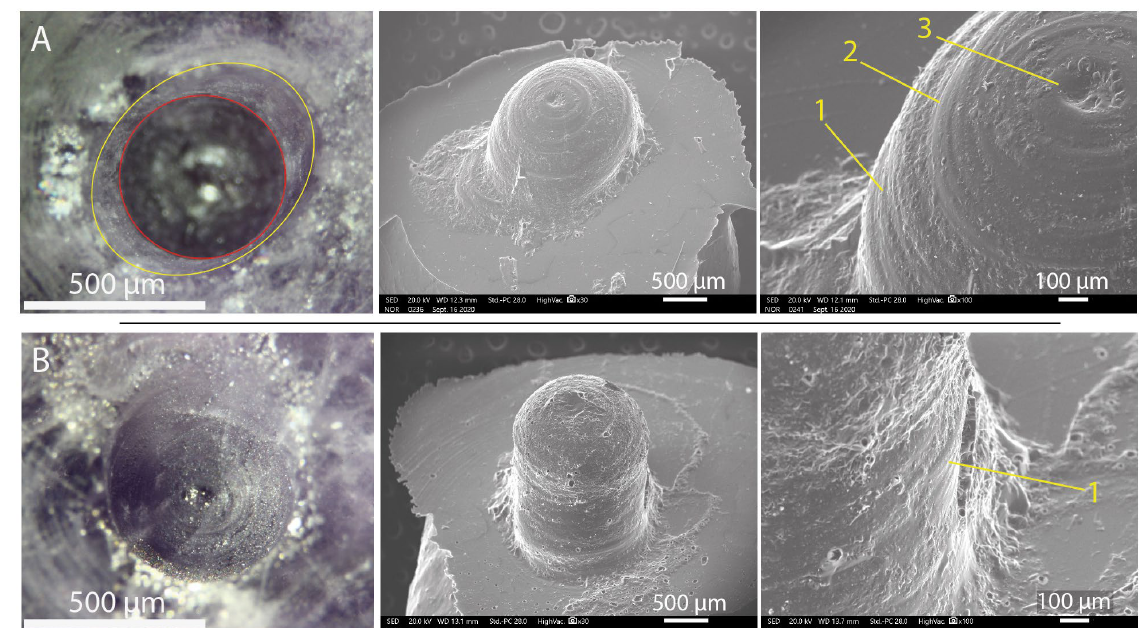
Figure 17: Microphotographies of experimental drillings and SEM image of the elastomer cast (20kV HV SS28 SED x30 et x100). A : amethyst with quartz abrasive and drill made of Melocactus intortus thorns, B : amethyst with garnet abrasive and drill made of Melocactus intortus thorns. Fine